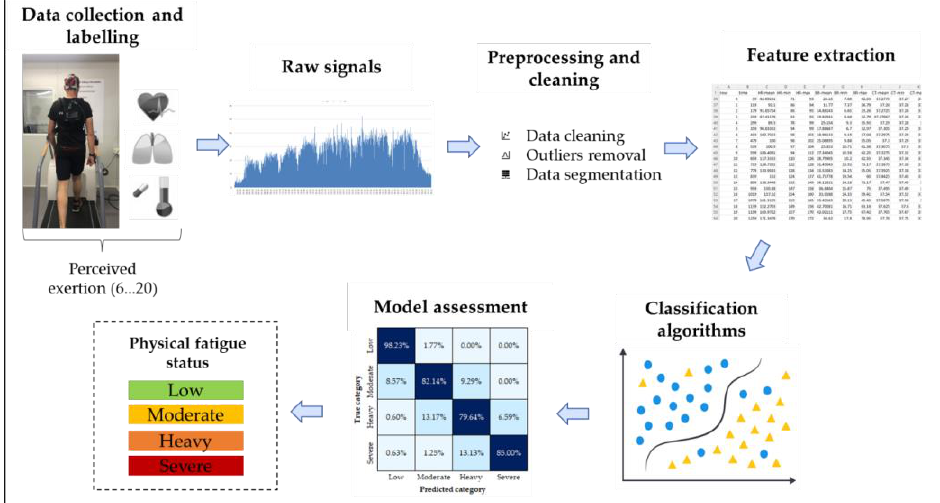
Figure 1. Methodology employed for implementing the physical exertion classification model.